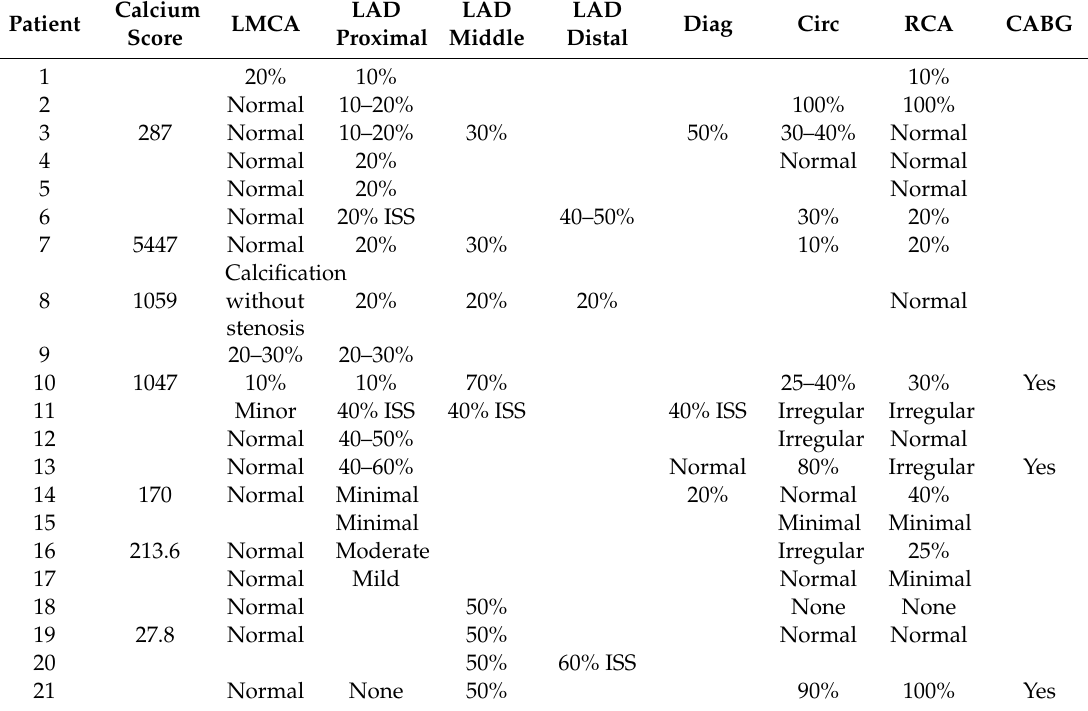
Table 5. Left heart catheterization (LHC) findings, location and percentage stenosis when data available. Note: Patients do not correlate to patients list in Table